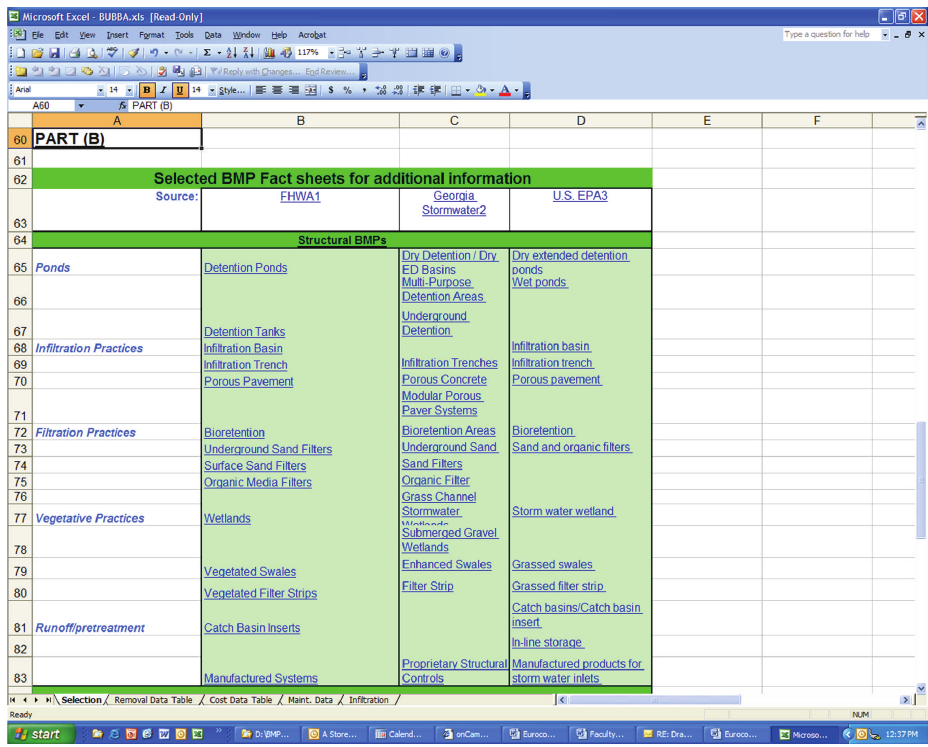
Figure 2: Part B of the Selection